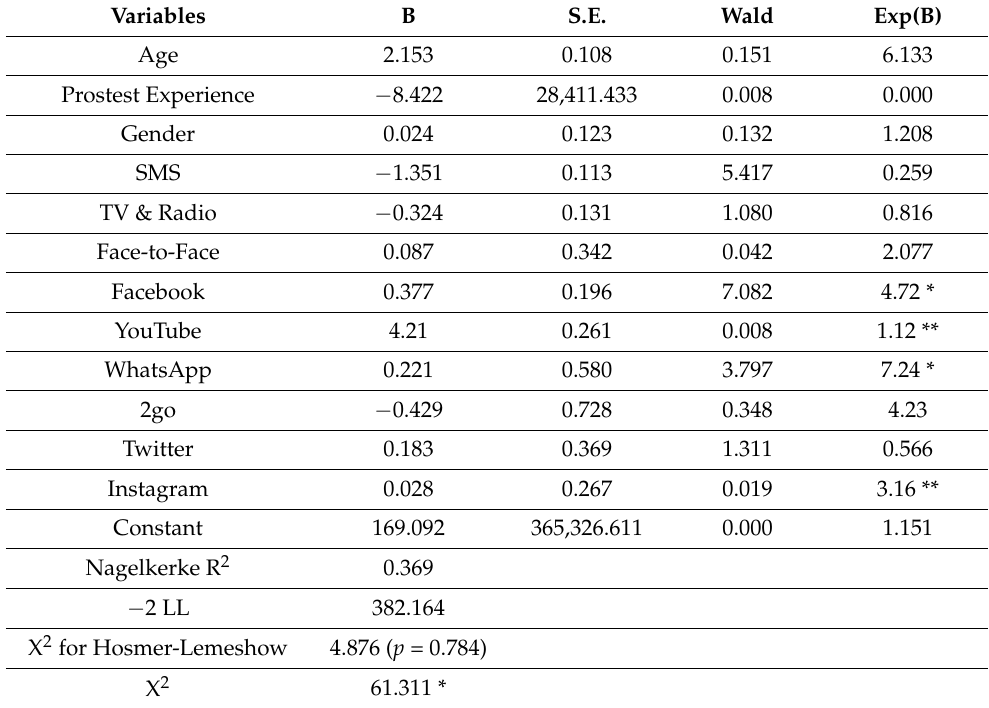
Table 1. Media used to document protest participation and joining on the first day of the